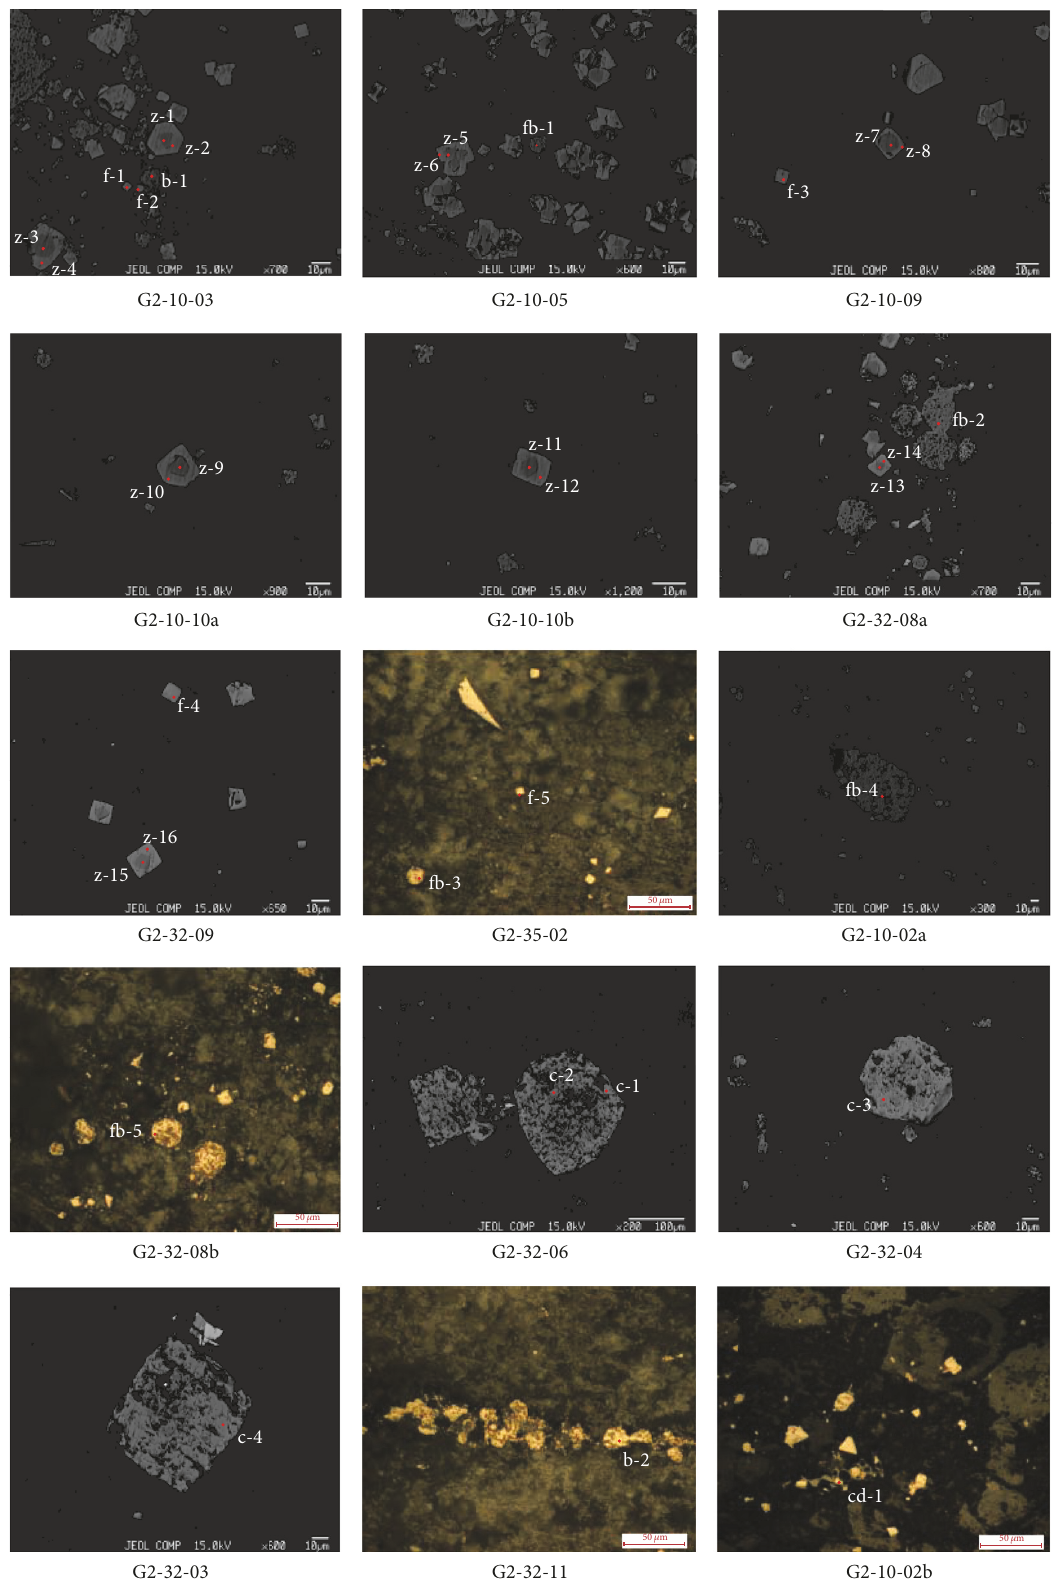
Figure 4: Microphotographs showing the structures of arsenian pyrite . EPMA analysis points are marked by red dots and the data are given in Table 3. The black-and-white images are EPMA BSE images, while the color images were taken under reflected light. Z, zoned pyrite; F, fine-grained pyrite; C, coarse-grained pyrite; B, banded pyrite; Fb, framboidal pyrite; and Cd, charcoal debris